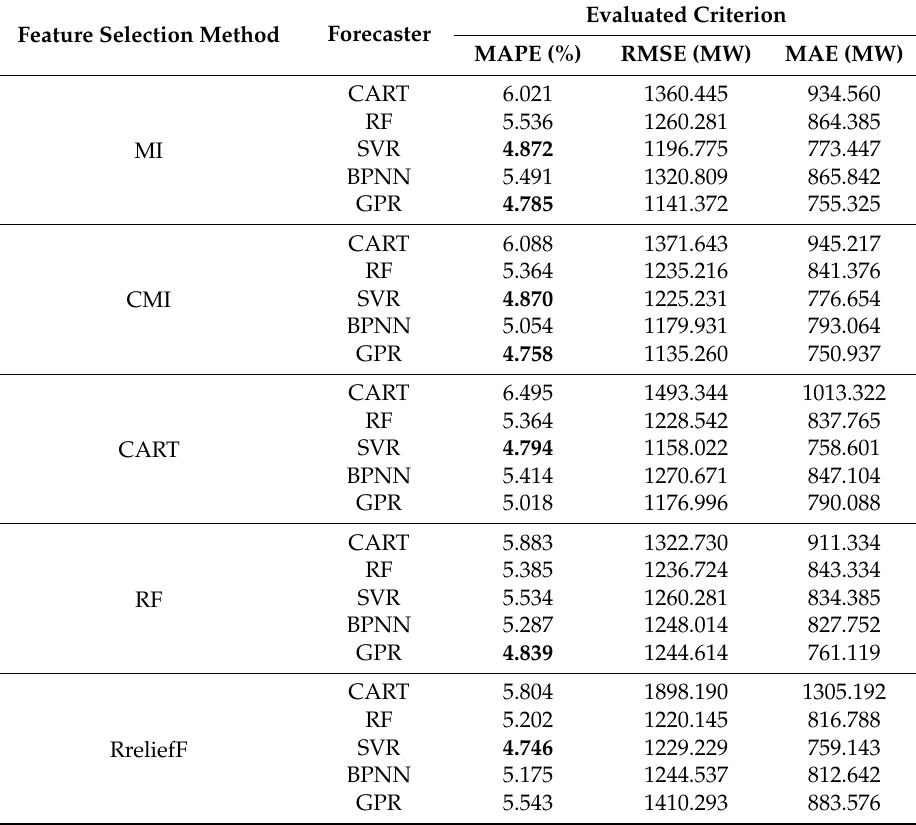
Table 8. Error of load forecasting of different methods with proposed forecasting approach for the whole test